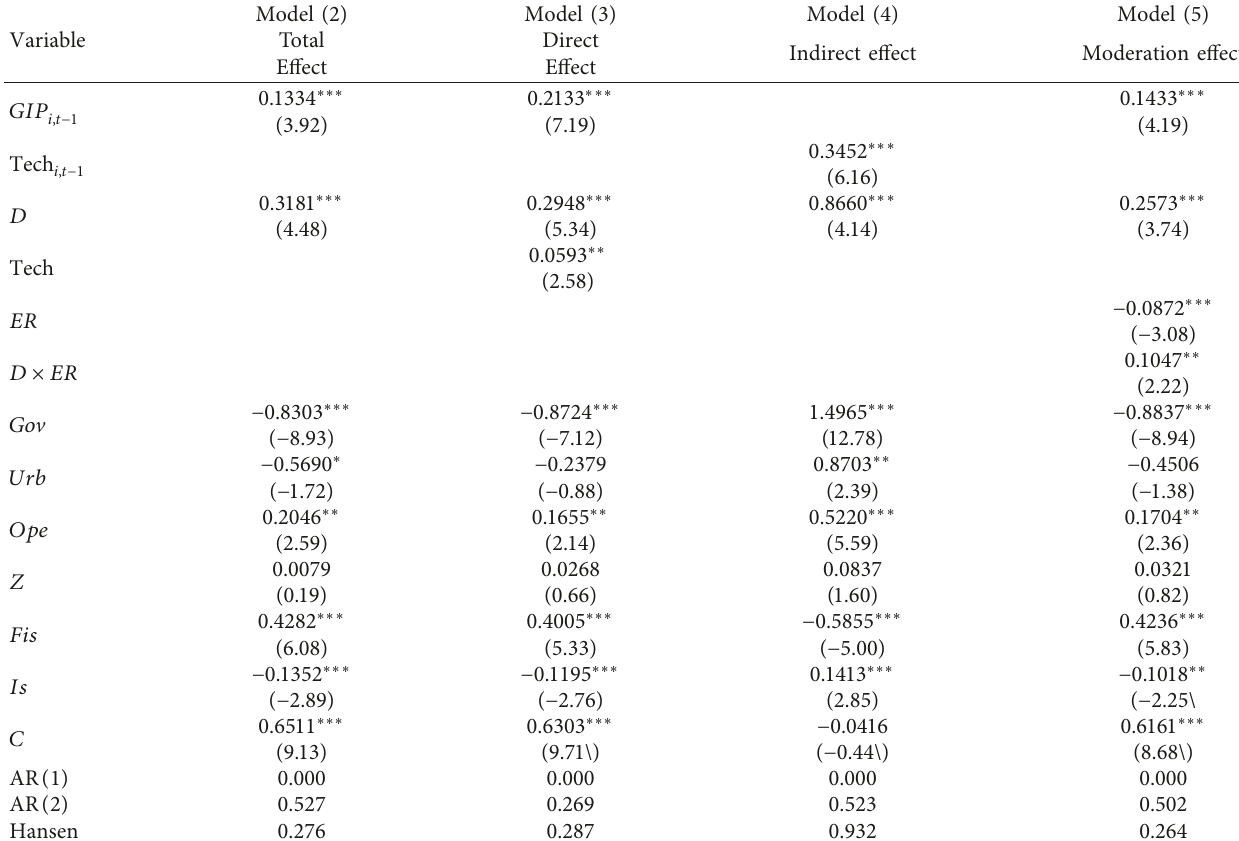
Table 6: Mechanism test results of digitalization on green innovation